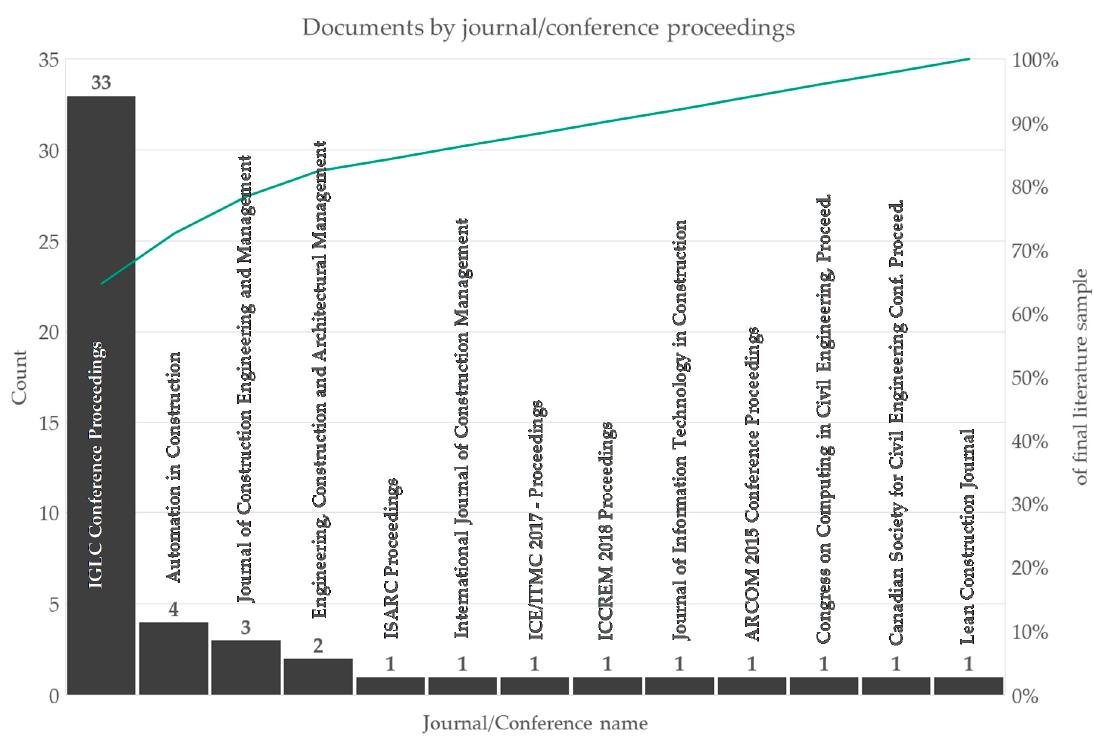
Figure 8. Documents by journal / conference proceedings. Table 7. Relevant sub-clusters and abstract groups for content analysis.